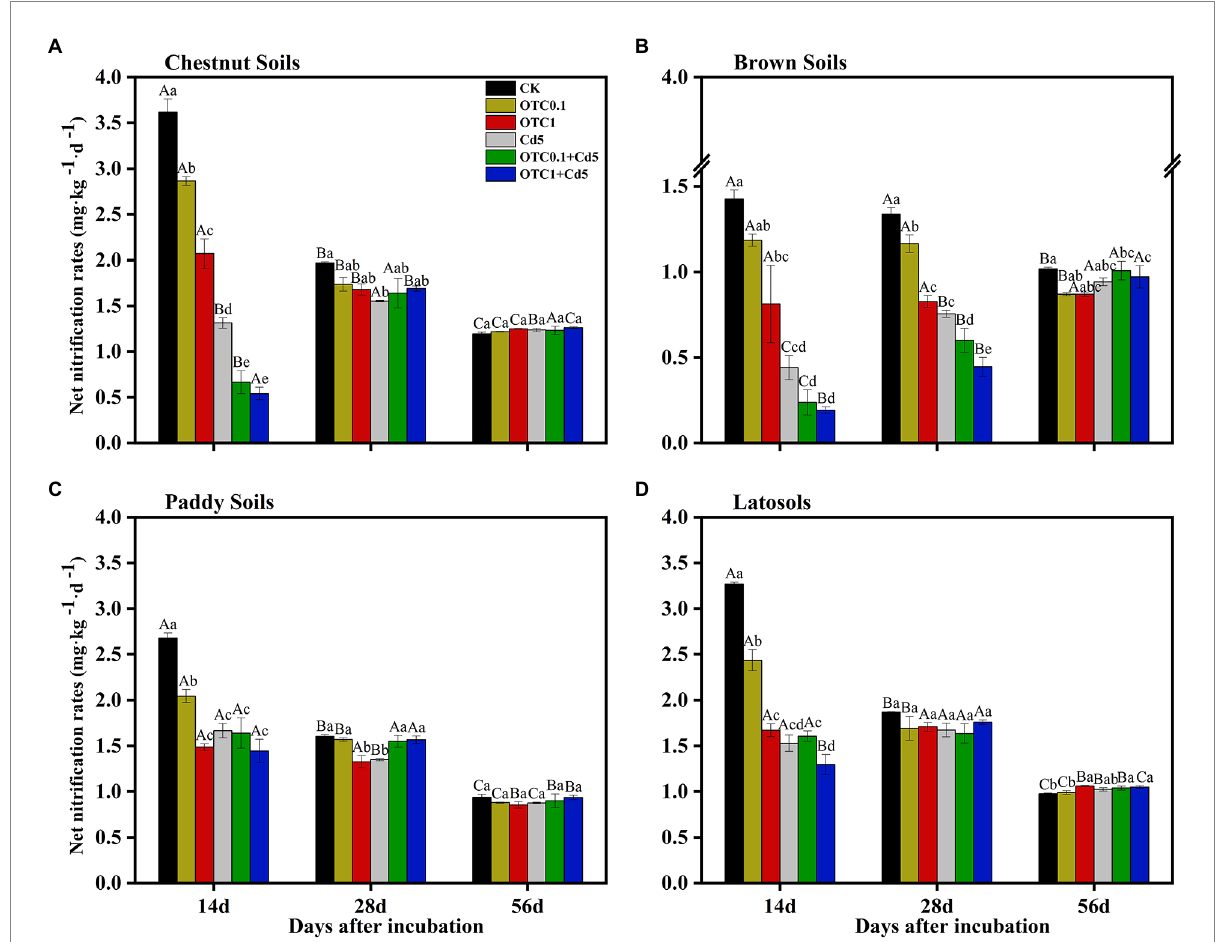
FIGURE 2 Dynamics of NNRs in chestnut soils (A) , brown soils (B) , paddy soils (C) , and latosols (D) under CK, OTC0.1, OTC1, Cd5, OTC0.1 + Cd5, and OTC1 + Cd5 treatments over the 56-day incubation. The vertical bars indicated the standard errors of the mean of triplicate samples. Different lowercase letters above the error bars indicated significant differences among treatments ( p < 0.05). Different uppercase letters above the error bars indicated significant differences among sampling time points under the same treatment ( p < 0.05). CK, control treatment without